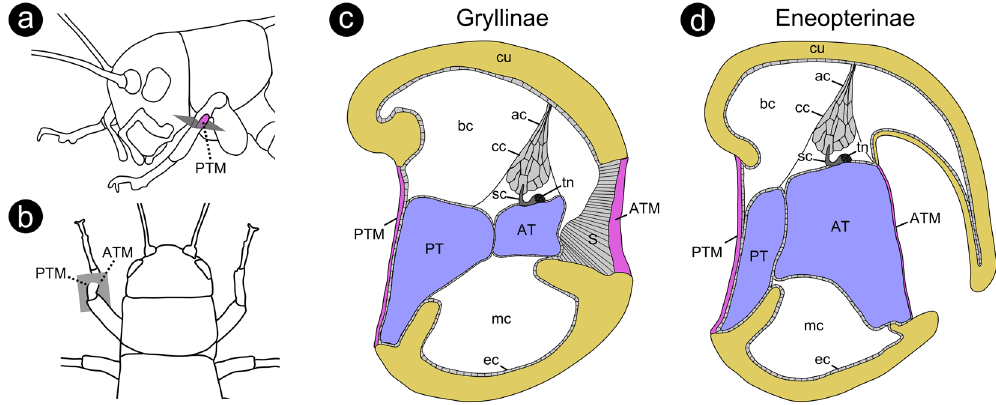
Figure 1. Schematic drawings of tympanal hearing organs in crickets. ( a ) Cricket from side view and ( b ) from top view, illustrating the relative position and orientation of the cutting plane (grey rectangle) along which cross-sections through the hearing organs were made in the present study. ( c ) Schematic cross-section through a typical tympanal ear of the subfamily Gryllinae and ( d ) of the subfamily Eneopterinae, showing the main structural and sensory components. Orientation in ( c and d ): top = lateral; bottom = medial; left = posterior; right = anterior. Colour code: yellow = cuticular portion of the tibia; magenta = cuticular portion of the tympanal membranes; blue = interior of tracheal branches. Abbreviations: ac = attachment cell; AT = anterior tracheal branch; ATM = anterior tympanal membrane; bc = blood channel; cc = cap cell; cu = cuticle; ec = epidermal cell; mc = muscle channel; PT = posterior tracheal branch; PTM = posterior tympanal membrane; S = suspensorium; sc = sensory cell; tn = tympanal